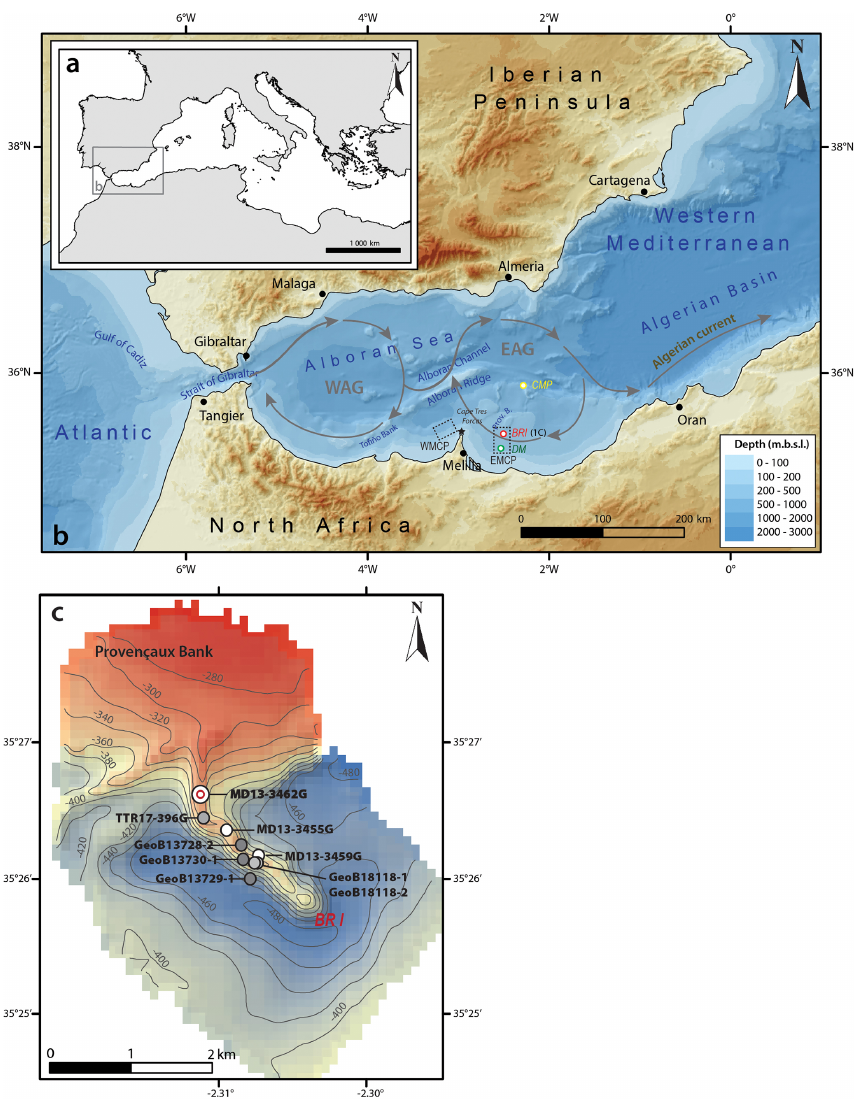
Figure 1. Location of the study area. (a) General map of the Mediterranean Sea and location of the investigated region. (b) Bathymetric map of the western Mediterranean Sea based on the GEBCO_2019 gridded bathymetric data. Yellow, red, and green dots respectively indicate the locations of the Cabliers Coral Mound Province (CMP), Brittlestar Ridge I (BRI), and Dragon Mound (DM). Additional abbreviations: EMCP – East Melilla Coral Province; WMCP – West Melilla Coral Province; WAG – Western Alboran Gyre; EAG – Eastern Alboran Gyre. (c) Bathymetry and location of the Provençaux Bank and Brittlestar Ridge I (BRI). The location of the studied core MD13-3462G